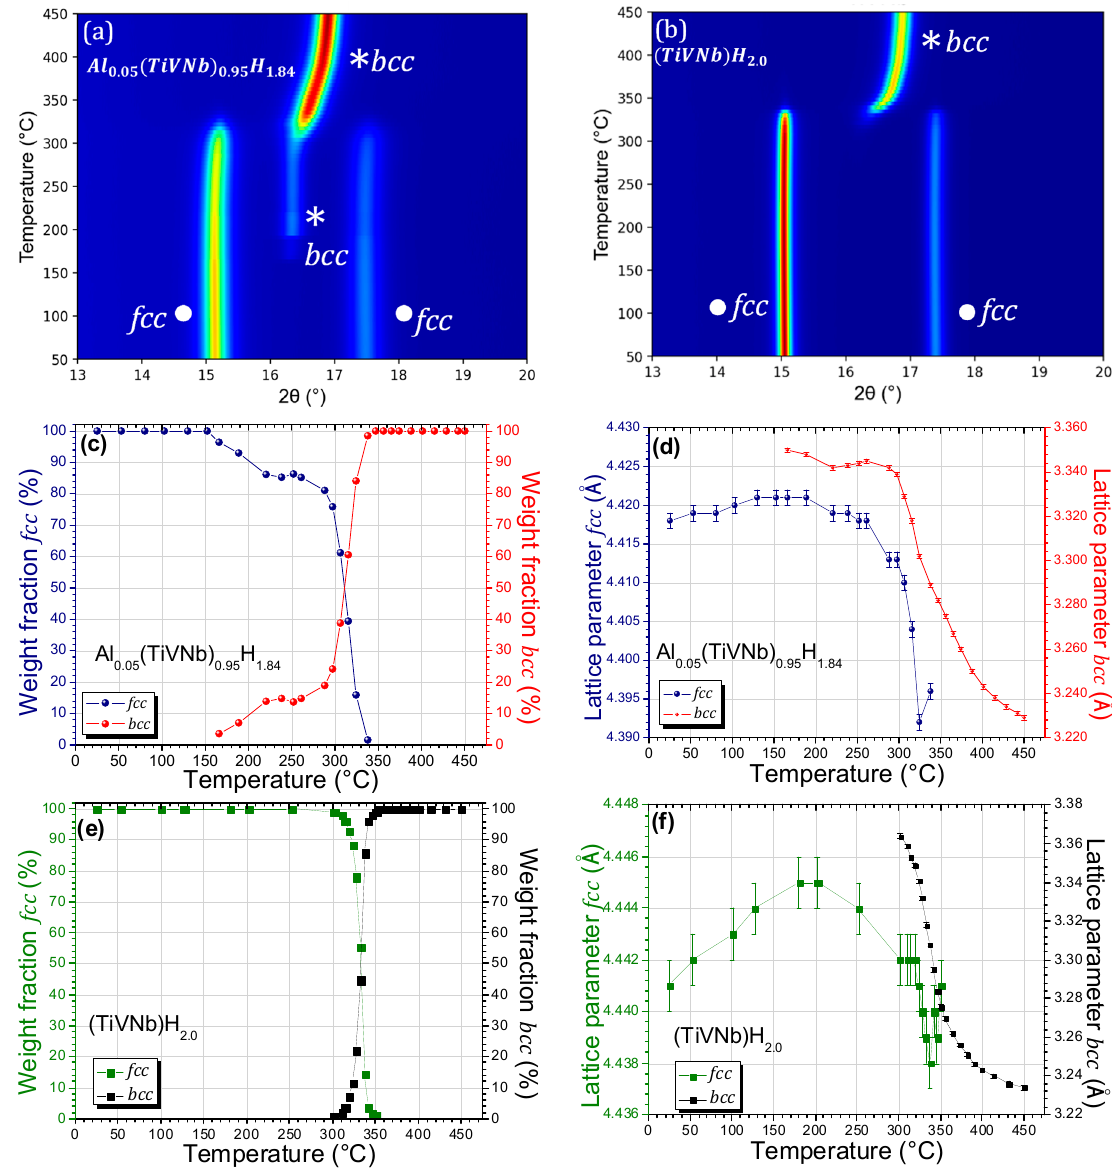
Figure 7. In situ SR-XRD thermo-diffractograms ( λ = 0.67156 Å) during hydrogen desorption from ( a ) Al 0.05 (TiVNb) 0.95 H 1.84 and ( b ) (TiVNb)H 2.0 under dynamic vacuum from 25 °C up to 450 °C (2 °C/min). Thermal evolution of phase fractions from ( c ) Al 0.05 (TiVNb) 0.95 H 1.84 and ( e ) (TiVNb)H 2.0 . Thermal evolution of fcc/bcc lattice parameters from ( d ) Al 0.05 (TiVNb) 0.95 H 1.84 and ( f ) (TiVNb)H 2.0 . If both alloys undergo a reversible two-step reaction: bcc phase (cid:29) bcc monohy- dride (cid:29) fcc dihydride, as demonstrated by the PCI curves and the ex situ SR-XRD measurement, the question arises: why was the transition from the bcc monohydride to the desorbed bcc phase not visible from the in situ SR-XRD? Presently, the